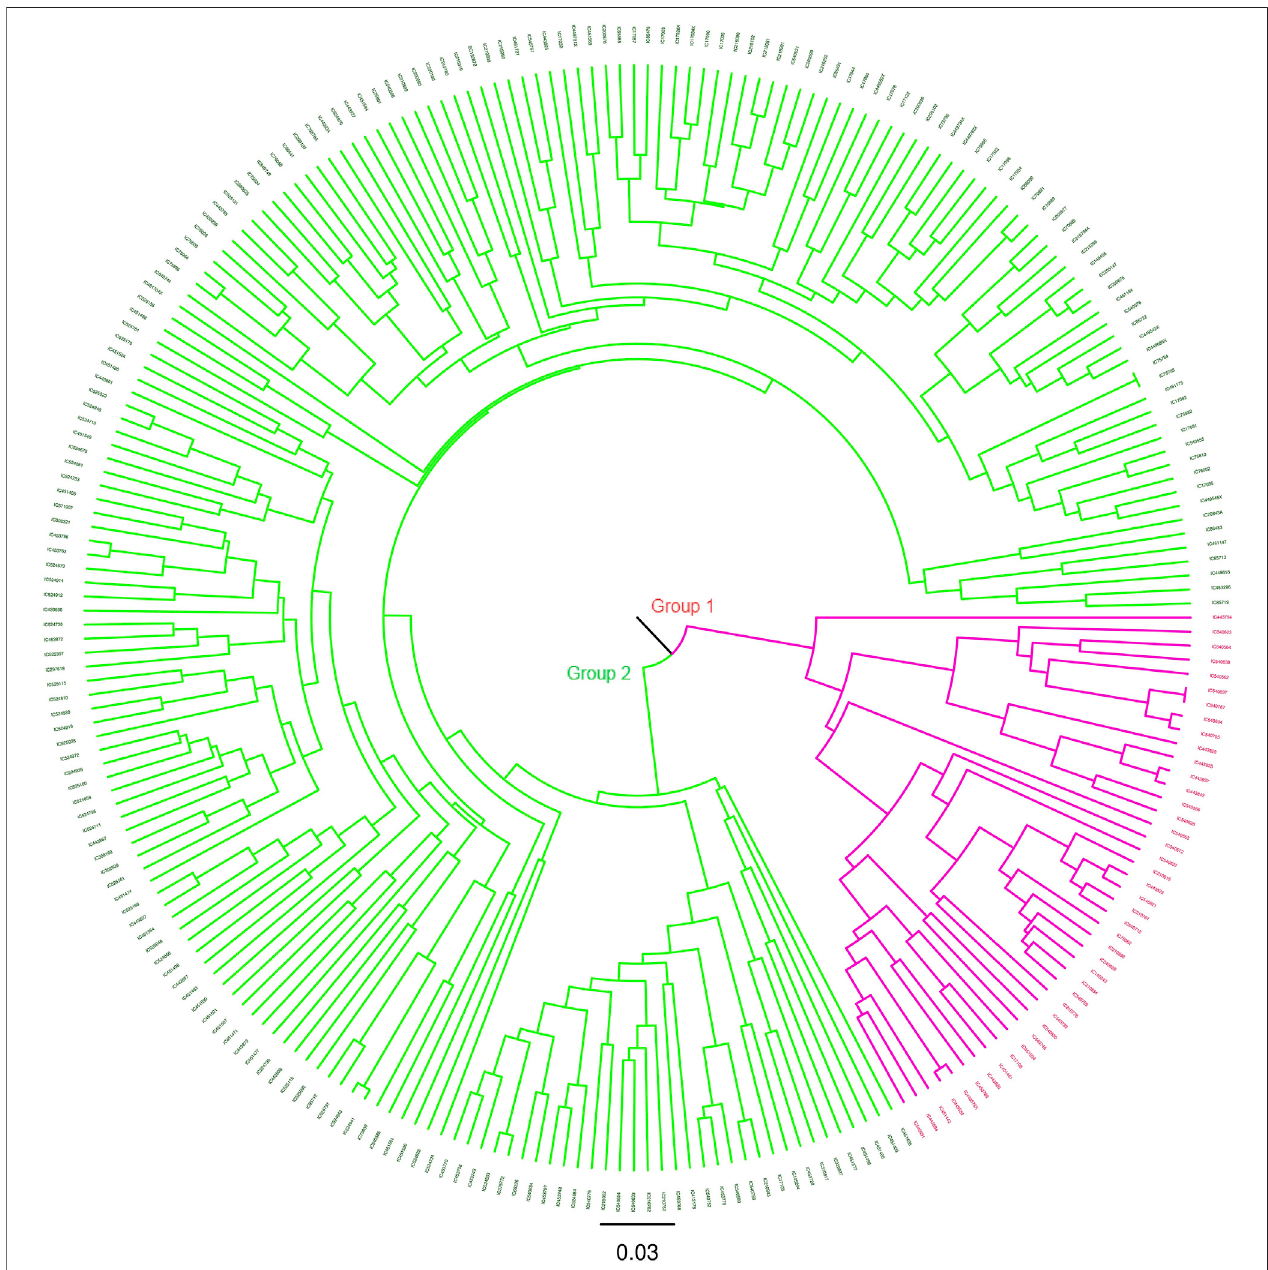
FIGURE 5 | NJ tree of the 247 east coast core